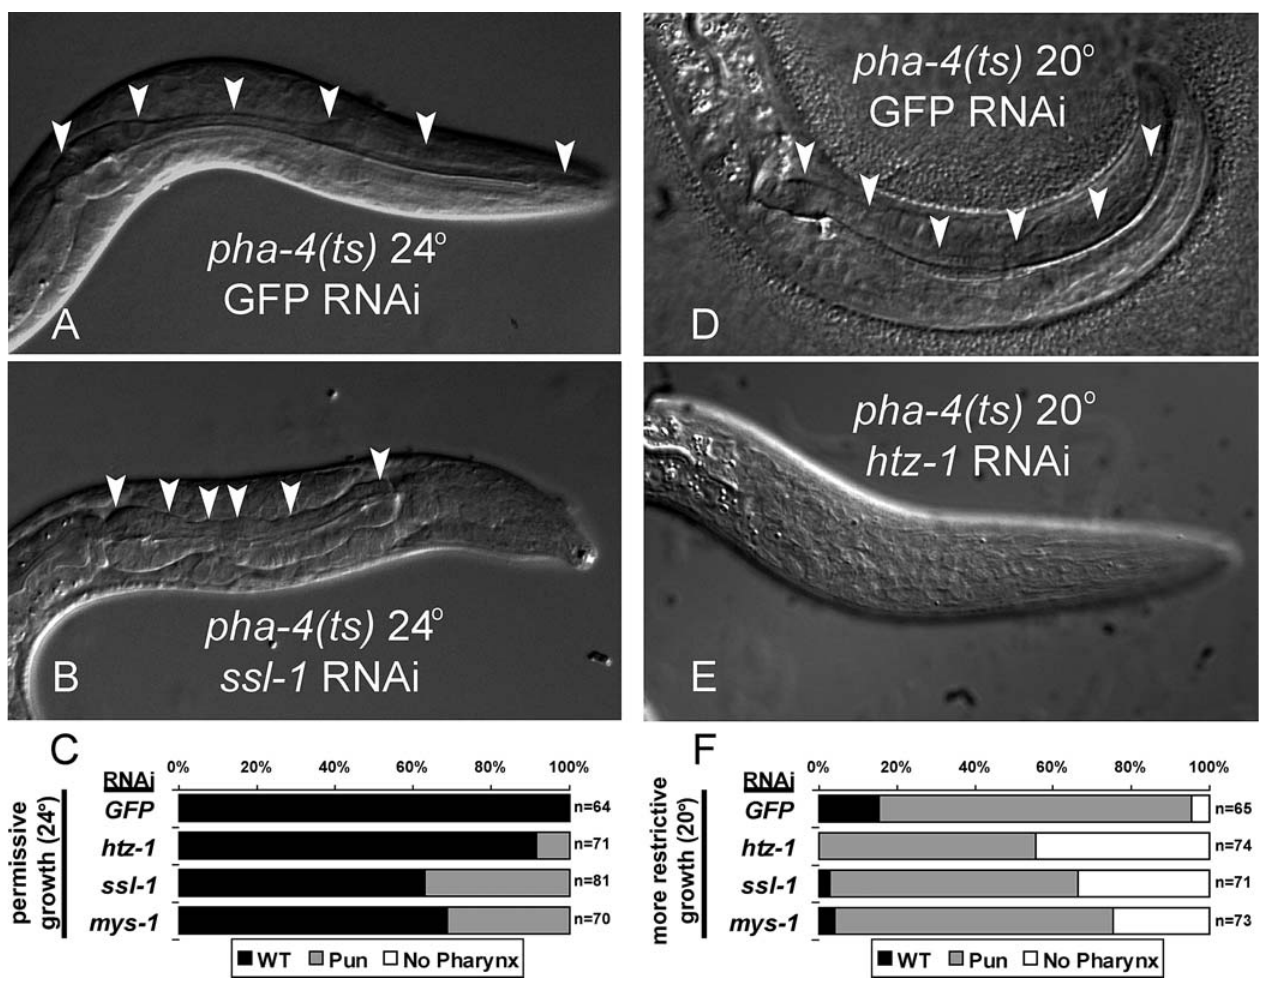
Figure 2. mys-1, ssl-1, and htz-1 Enhance Pharyngeal Defects of pha-4(ts) (A–C) Feeding dsRNA to pha-4(ts) worms at the permissive temperature of 24 8 C. (A) A pha-4(ts); GFP(RNAi) L1 with a wild-type pharynx (arrowheads). (B) A pha-4(ts); ssl-1(RNAi) L1 with an unattached pharynx (arrowheads). (C) Quantitation of pha-4(ts) animals exhibiting a normal pharynx (WT), an unattached or incomplete pharynx (Pun), or no detectable pharynx. htz-1,